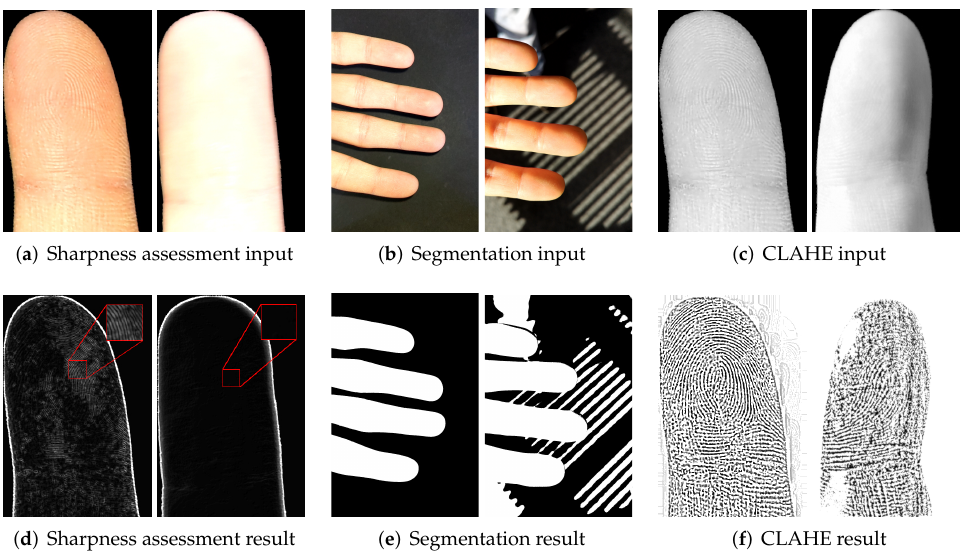
Figure 17. Illustration of accurate and challenging input images and corresponding result images for sharpness assessment ( a , d ), segmentation ( b , e ), and contrast adjustment ( c , f ). The left images of each block represent an accurate image; the right one—a challenging